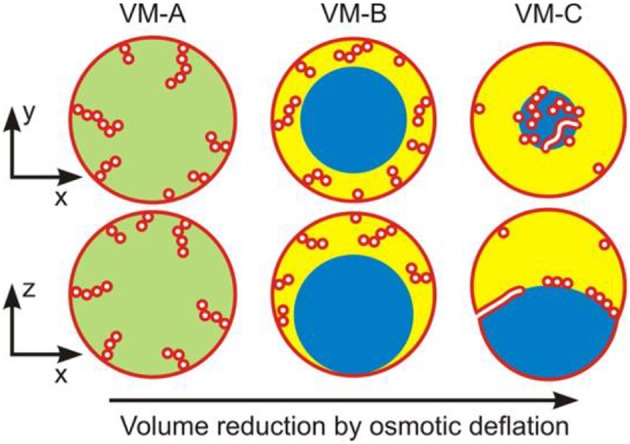
Three nanotube patterns (VM-A, VM-B, and VM-C) corresponding to the distinct vesicle morphologies (VM) observed along the deflation path: Schematic views of horizontal xy-scans (top row) and of vertical xz-scans (bottom row) across the deflated vesicles. In all cases, the tubes are filled with external medium (white); the membrane is shown in red. For the VM-A morphology, the interior polymer solution is uniform (green), whereas it is phase-separated (blue and yellow) for the morphologies VM-B and VM-C, with complete and partial wetting, respectively, of the membrane by the PEG-rich aqueous phase (yellow). For the VM-B morphology, the nanotubes explore the whole PEG-rich (yellow) droplet but stay away from the dextran-rich one (blue). For the VM-C morphology, the nanotubes adhere to the interface between the two aqueous droplets forming a thin and crowded layer over this interface. It is expected that in the VM-A and VM-B morphologies, these nanotubes are necklace-like consisting of a number of small spheres connected by narrow or closed membrane necks, while in the VM-C morphology, cylindrical tubes with a uniform diameter along the nanotubes co-exist with the necklace-like ones. Reprinted with permission from Liu et al. (2016). Copyright (2016) American Chemical Society.